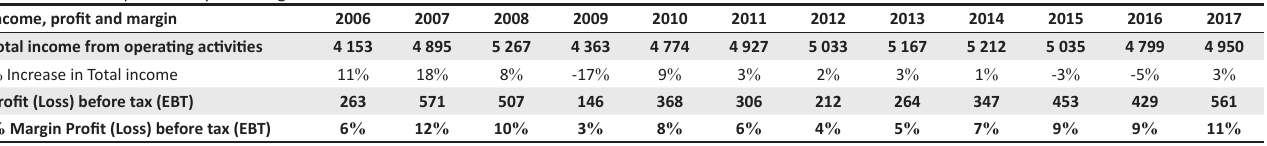
TABLE 10: SWISS’ profitability following Lufthansa’s takeover. Income, profit and